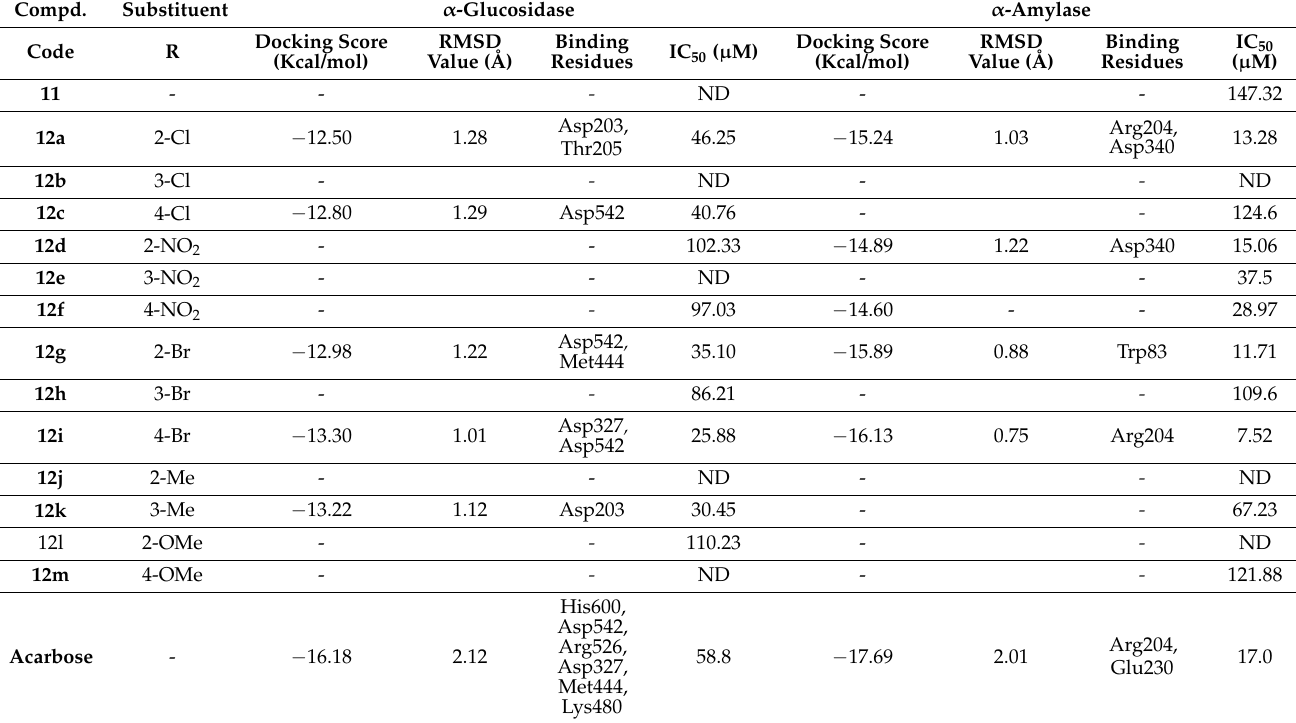
Table 1. Structural parameters and in silico (docking scores and binding residues) and in vitro (IC 50 values) analysis of 1,2-benzothiaine- N -arylacetamides 12a–m against α -glucosidase and α - amylase